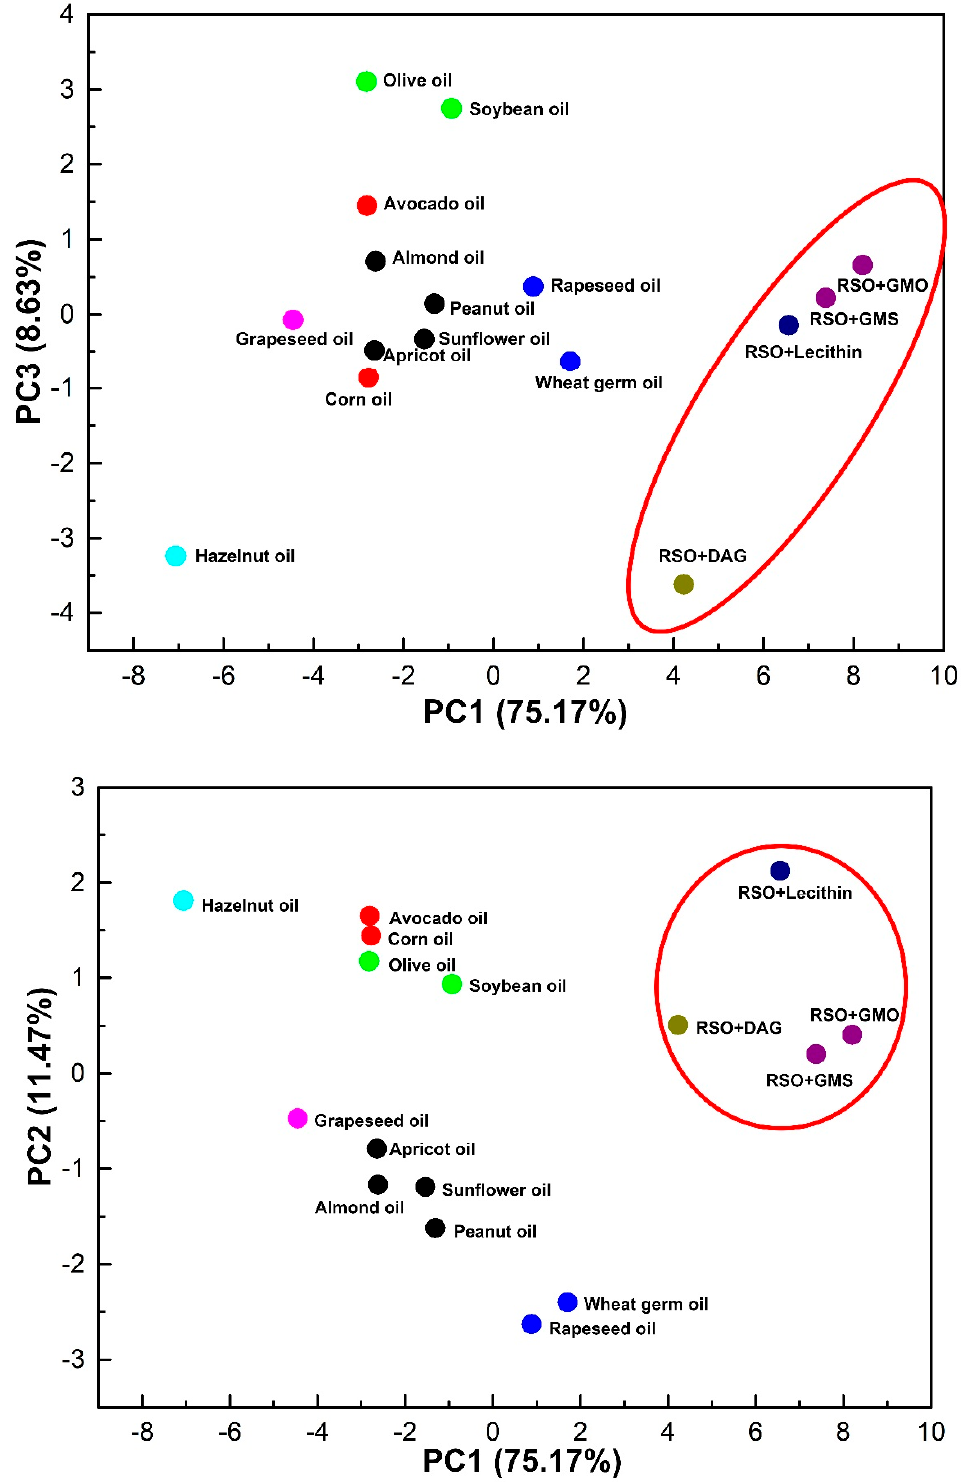
Figure 5. Dissolving power of oily solvents in principal component analytical plots (PC1 versus PC2 and PC1 versus PC3) corresponding to volatile and non-volatile bioactive compounds extracted.